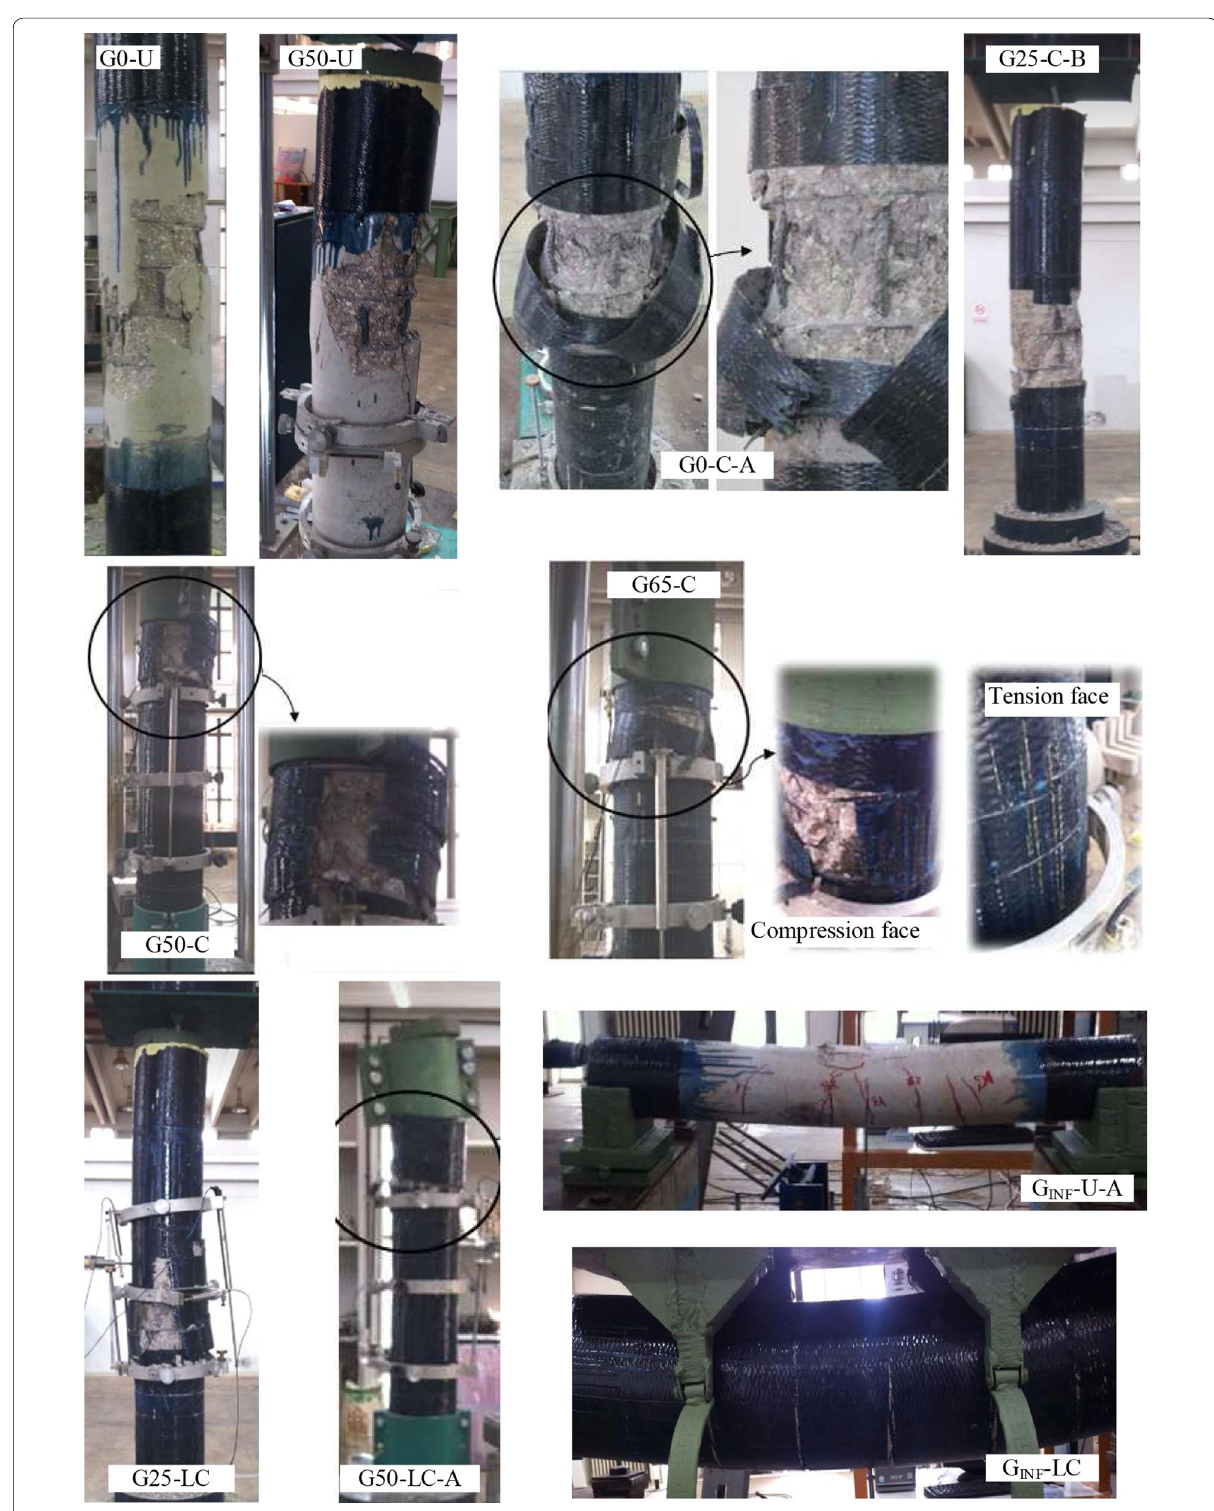
Fig. 5 Examples of observed failure patterns in test